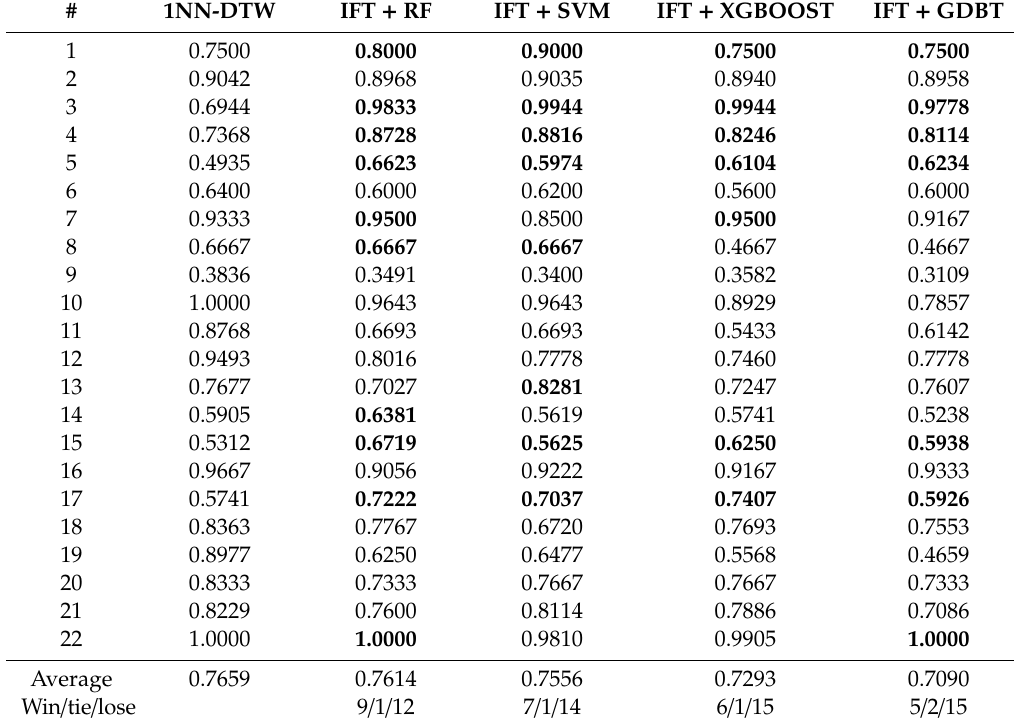
Table 2. Testing accuracy of one-nearest-neighbor classifier with dynamic time warping (1NN-DTW) on raw data, and four interval feature transformation (IFT) classifiers. RF: Random Forest; SVM: Support